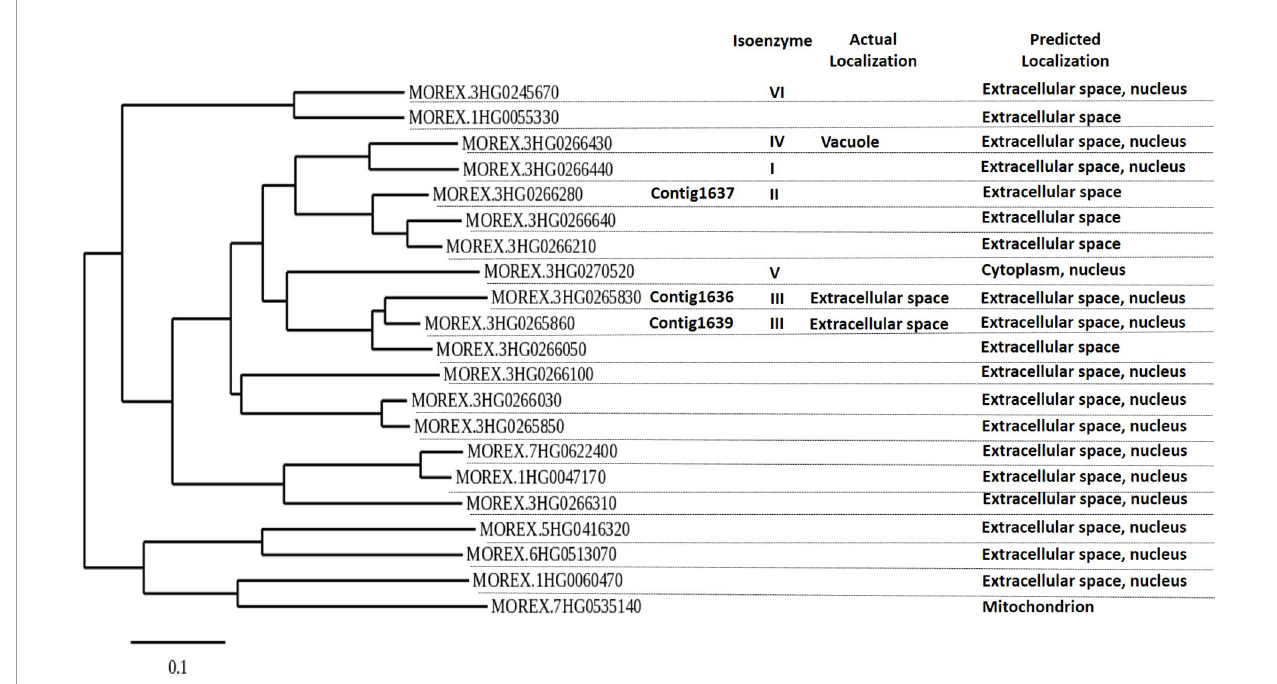
FIGURE 2 | Phylogenetic tree of putative barley b -1,3-glucanase genes based on barley cultivar Morex DNA sequence, using Phylogeny.fr (maximum likelihood with bootstraps) software. b -1,3-Glucanase contigs 1636, 1637, and 1639 are indicated. b -1,3-Glucanase Morex sequences were obtained on December 2019 after blasting 1636, 1637, and 1639 in IPK ’ s barley blast server (http://webblast.ipk-gatersleben.de/barley_ibsc/). Actual isoenzyme information and subcellular protein localization refer to information by Li et al. (1996) and UniProt.org. Predicted localization of expression is from Bologna uni fi ed subcellular component annotator (BUSCA) (http://busca.biocomp.unibo.it).